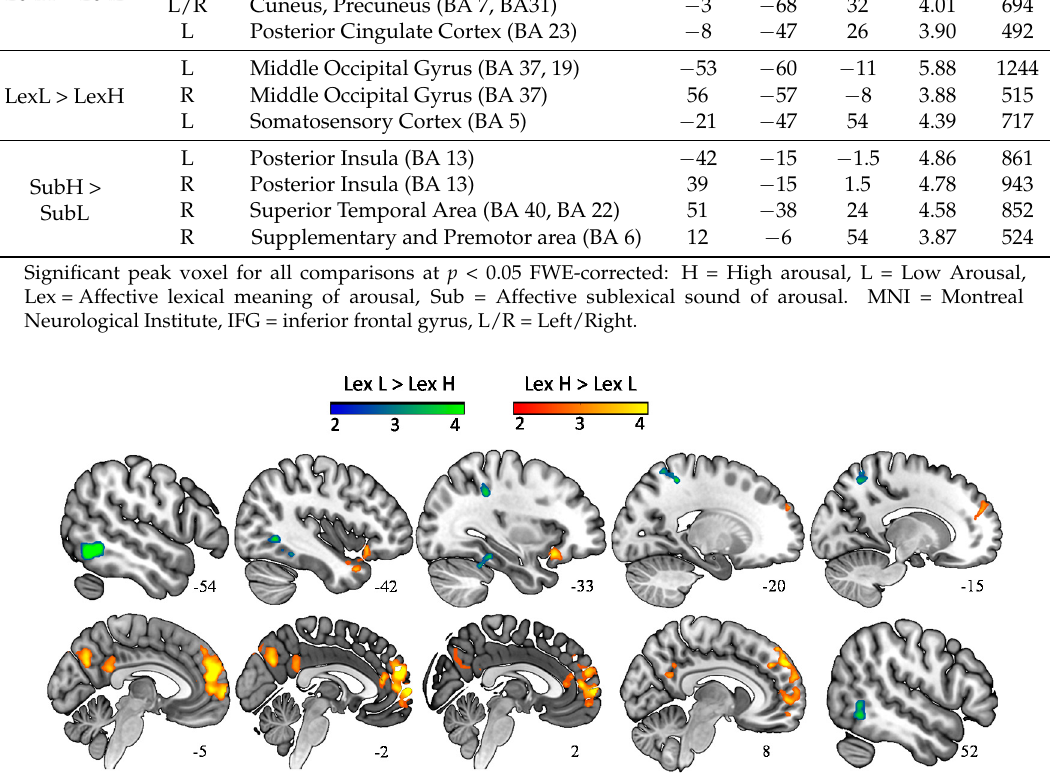
Figure 2. Words with a higher degree of lexical arousal (Lex H > Lex L) elicited stronger activation in